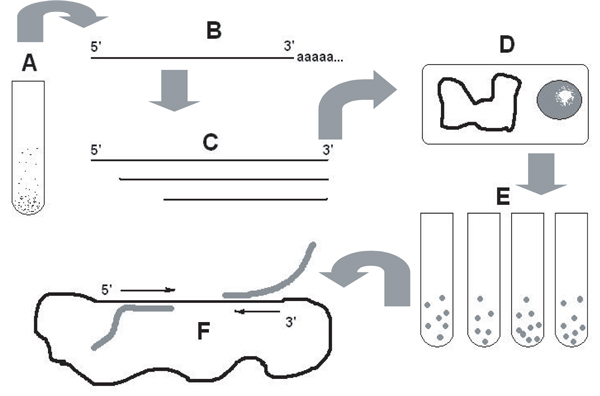
Schematic outline of a typical EST manufacture process. After a sample of interest (A) is collected all transcribed copies of expressed genes (mRNAs) are isolated (B). Each mRNA is reverse-transcribed into a complementary DNA (cDNA) (C). Note that cDNA copies may have different lengths due to the polymerase processivity. The copy number of those fragments is increased when they are inserted into a host cell (D). The resulting population of host cells, containing cDNA fragments from the sample of interest is called a cDNA library (E). Typically a few thousand clones are randomly picked from the cDNA library to produce single-pass reads from 3', more rarely from the 5' ends and sometimes from the random location in the middle (F). The resulting collection represents fragments of different lengths starting from the polyadenylation site at 3' end and partially overlapping fragments from 5' end, starting at different points. Although 3' and 5' ESTs rarely overlap, they usually share the same clone ID in the annotation.